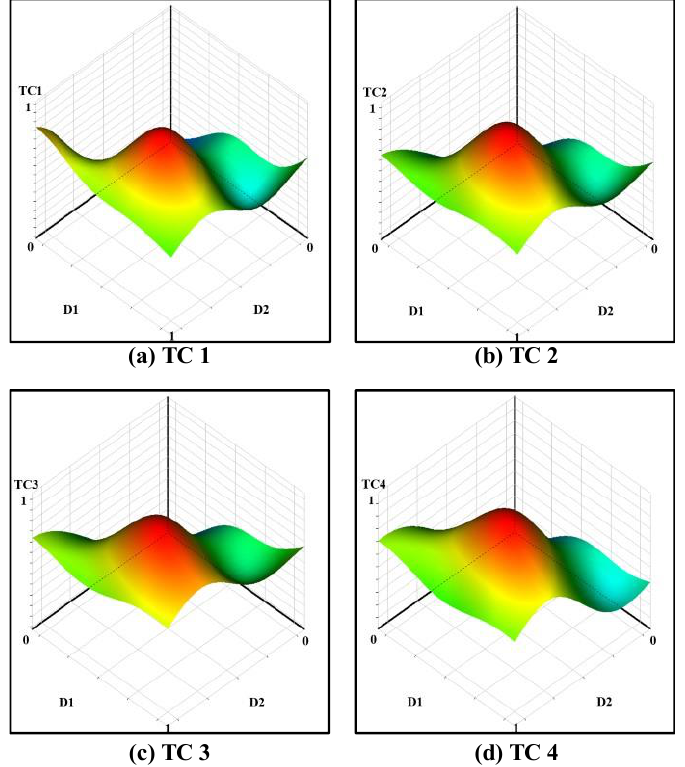
Figure 6. Response surface of non-parametric regression (0 to 1 normalized x,y and z axis).